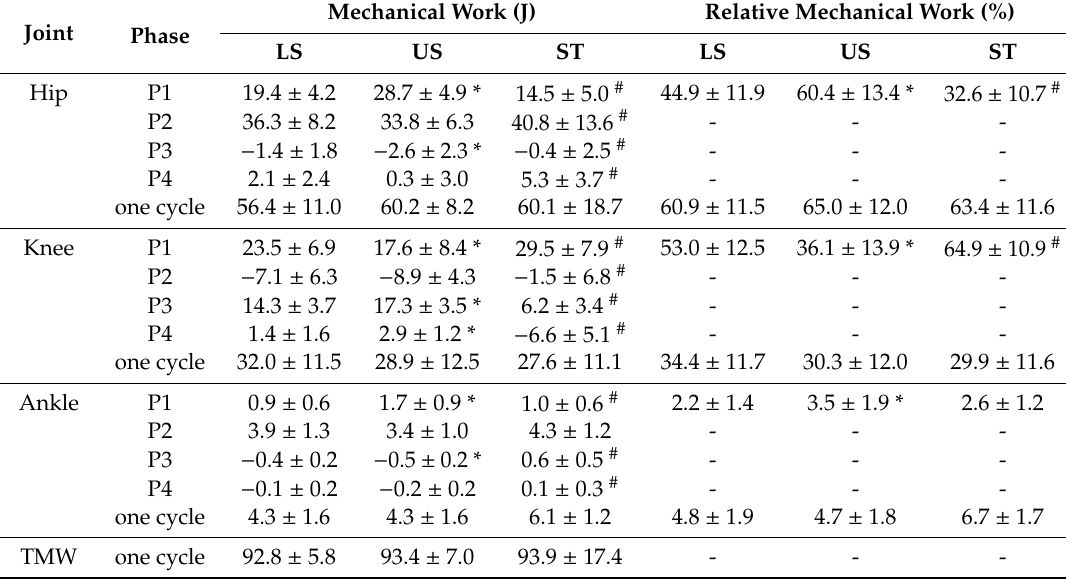
Table 2. Average ± SD results of the mechanical work of the ankle, knee and hip joints in the LS, US, and ST conditions from P1 to P4 and one crank cycle at a constant power output. Mechanical Work Joint Phase